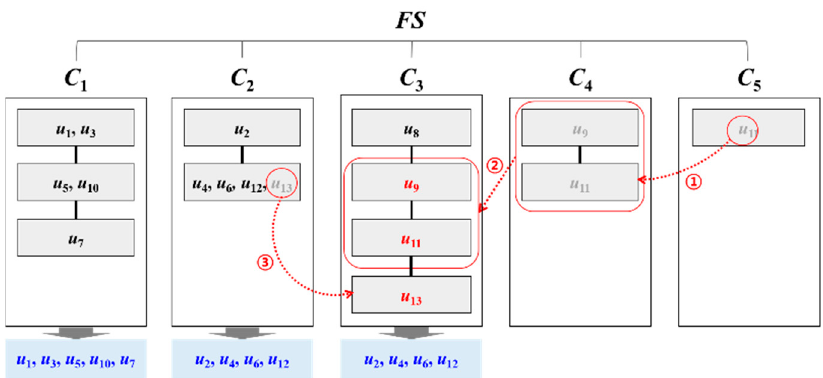
Figure 3. Final results after cluster merging.